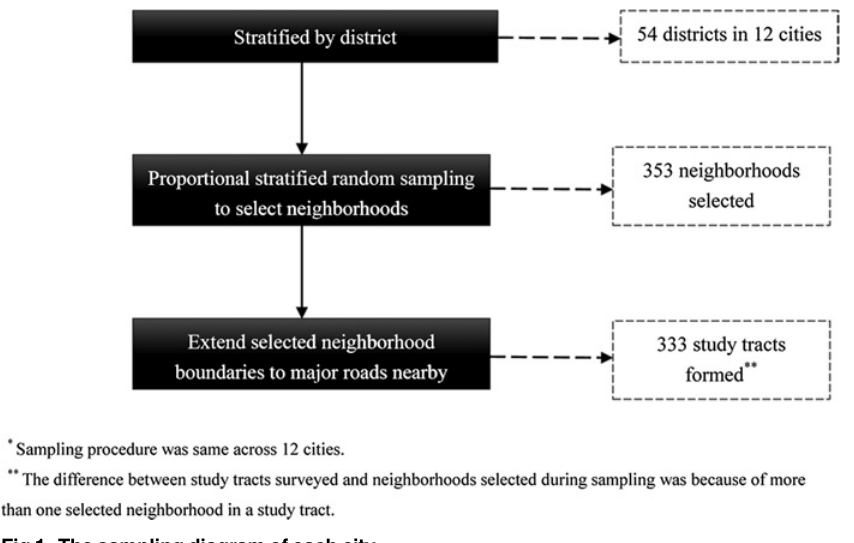
Fig 1. The sampling diagram of each